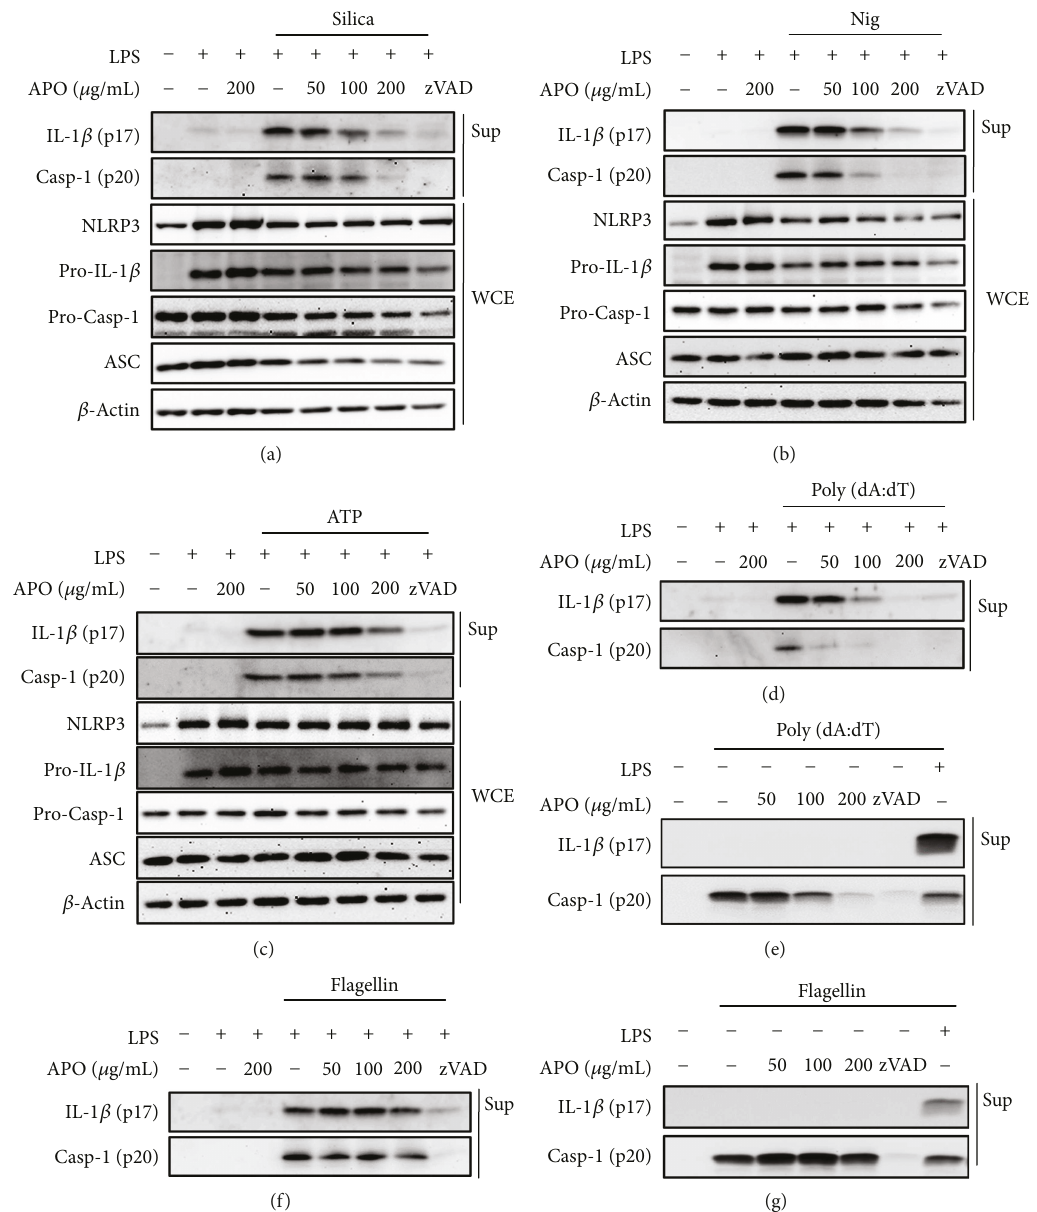
Figure 2: E ff ect of APO on in fl ammasome components. LPS-primed BMDMs (a – d, f) and nonprimed BMDMs (e, g) were pretreated with APO or zVAD (20 μ M) and stimulated with (a) 150 μ g/mL silica for 3 h, (b) 10 μ M nigericin for 1 h, (c) 5mM ATP for 1h, (d-e) 2 μ g/mL poly (dA:dT) for 1h, and (f-g) 1.5 μ g/mL fl agellin for 3 h. Mature IL-1 β and caspase-1 cleavage were measured in supernatant (Sup). NLRP3, pro- IL-1 β , procaspase-1, and ASC were measured in whole cell extract (WCE) by immunoblotting. β -Actin was used as an internal control. LPS, lipopolysaccharide; BMDMs, bone marrow-derived macrophages; APO, A. princeps extract; IL, interleukin; Nig,